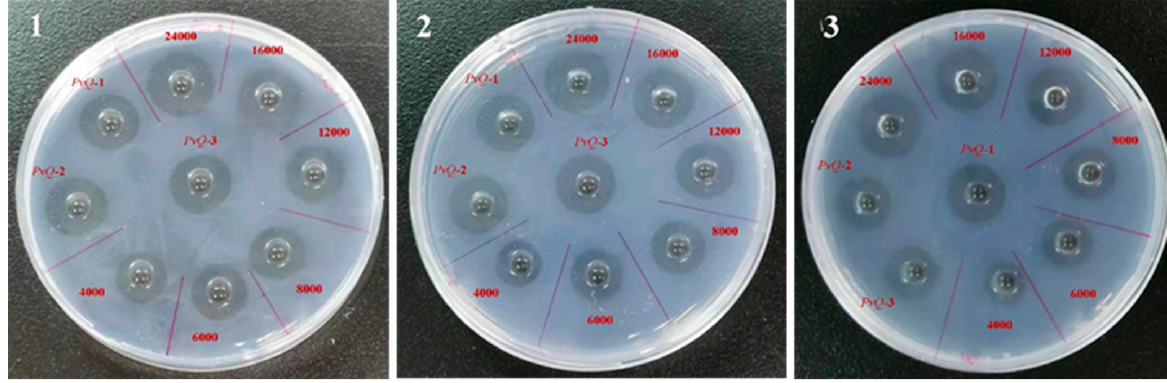
Figure 2. The fibrin-plate assay of PvQ and lumbrokinase. Table 1. The specific activity of PvQ (Mean ± SD, n = 3).